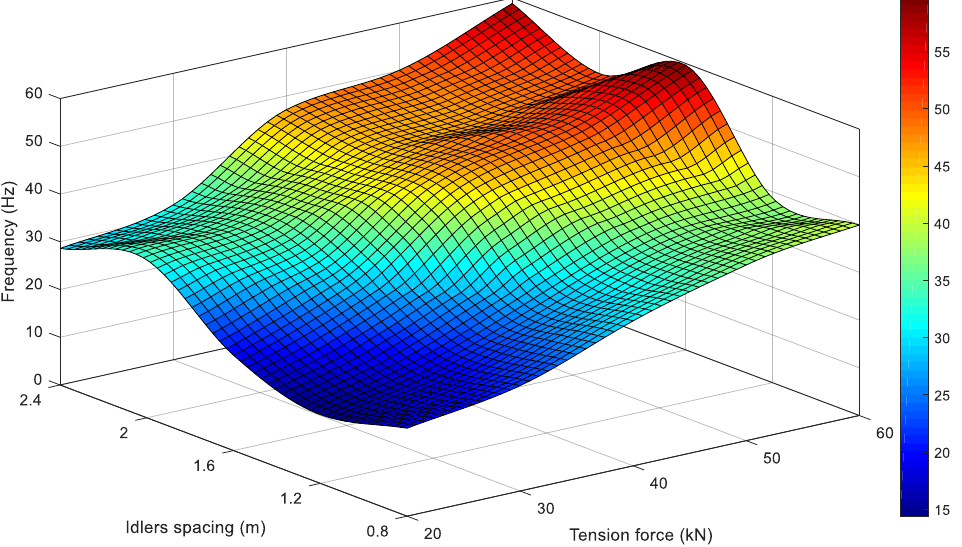
Figure 7. Frequency of belt transverse vibrations as a function of two measured parameters: belt tensile force and spacing between the idler supports.